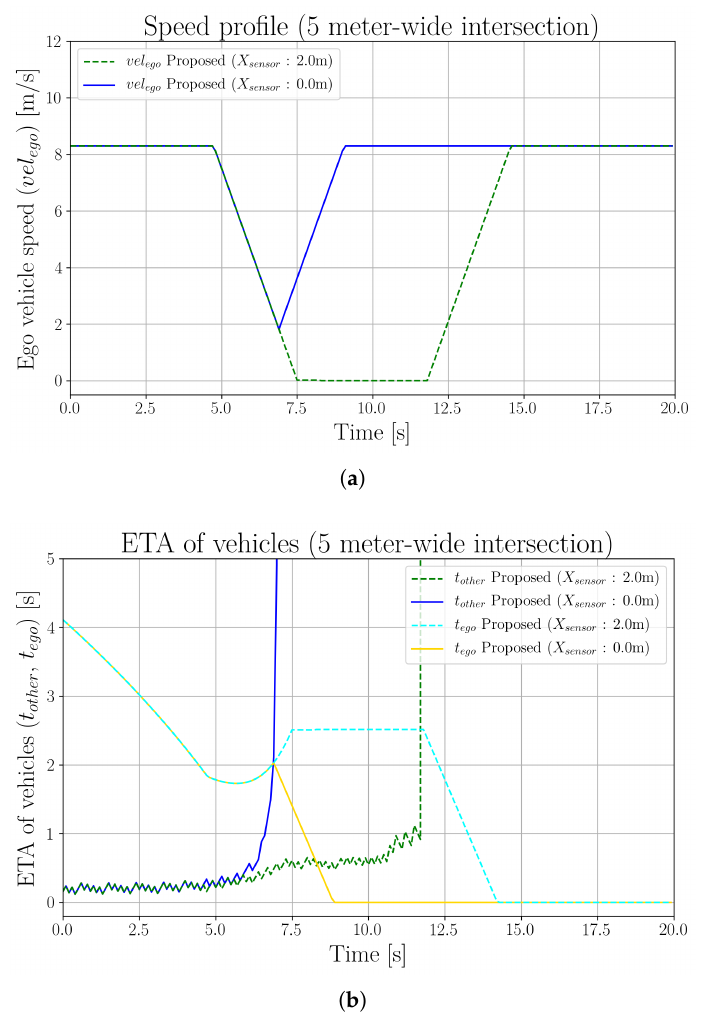
Figure 18. Comparison of the effects of sensor mounting position on planner output at a 5 m wide occluded intersection with the sensor located on the roof (2 m from front bumper) vs. on the front bumper (0 m from front bumper). ( a ) Ego vehicle speed profiles at a 5 m wide occluded intersection. ( b ) Estimated times of arrival of vehicles at a 5 m wide occluded